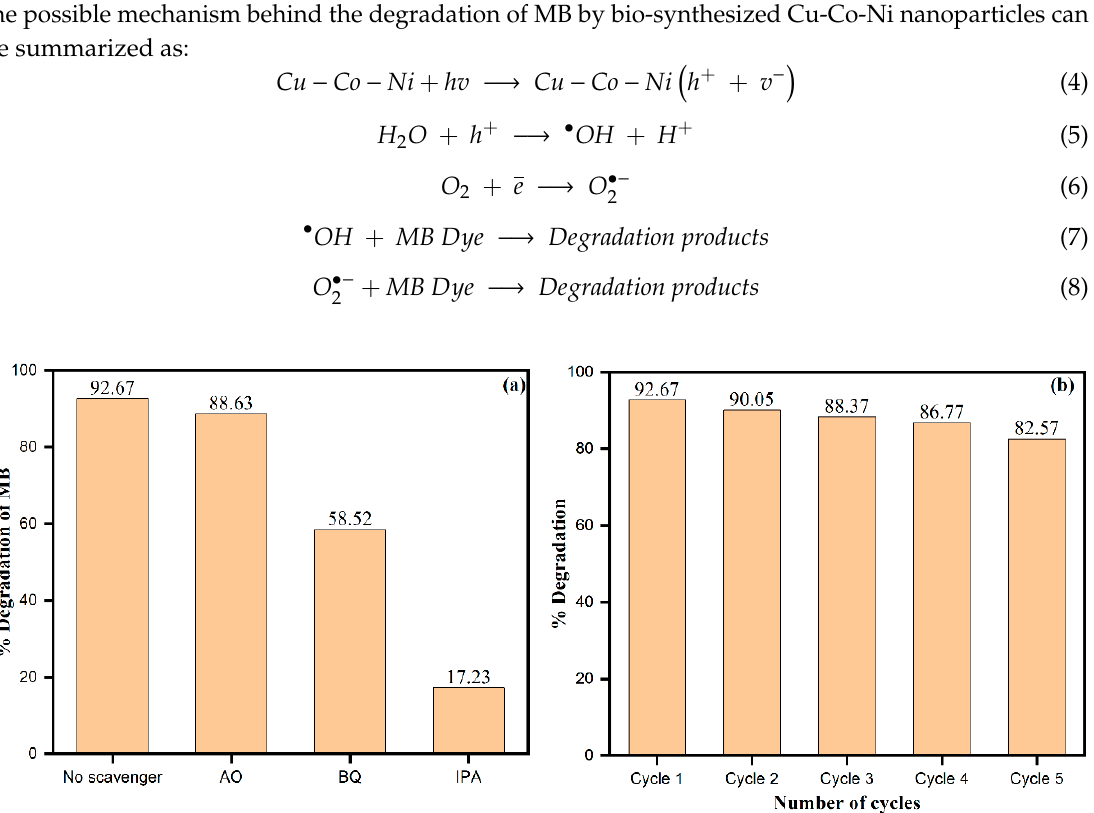
Figure 12. ( a ) Photocatalytic % degradation of MB in the presence of different scavengers over Cu-Co-Ni nanoparticles. ( b ) Stability and reusability of the photocatalyst.